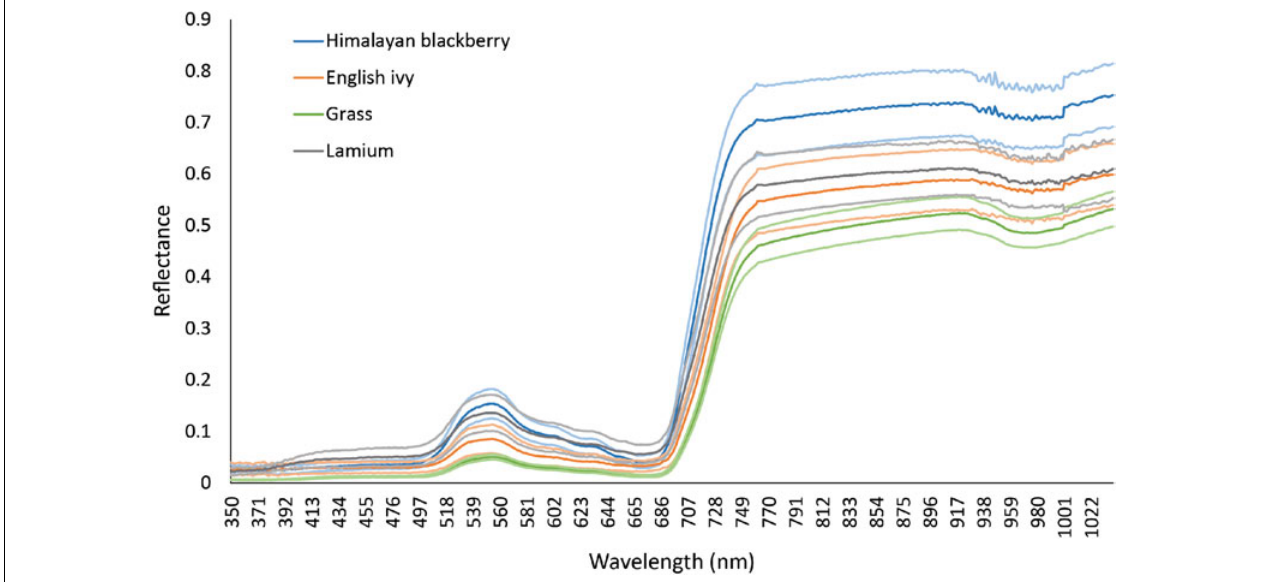
FIGURE 3 | Reflectance of Himalayan blackberry ( Rubus armeniacus ), English ivy ( Hedera helix ), grasses, and lamium ( Lamium galedo ... ) in Surrey, BC, Canada as obtained from an Analytical Spectral Devices spectrometer in the spectral range of the hyperspectral imagery. Mean reflectance is indicated by dark lines, and ± 1 standard deviation is indicated by the lighter